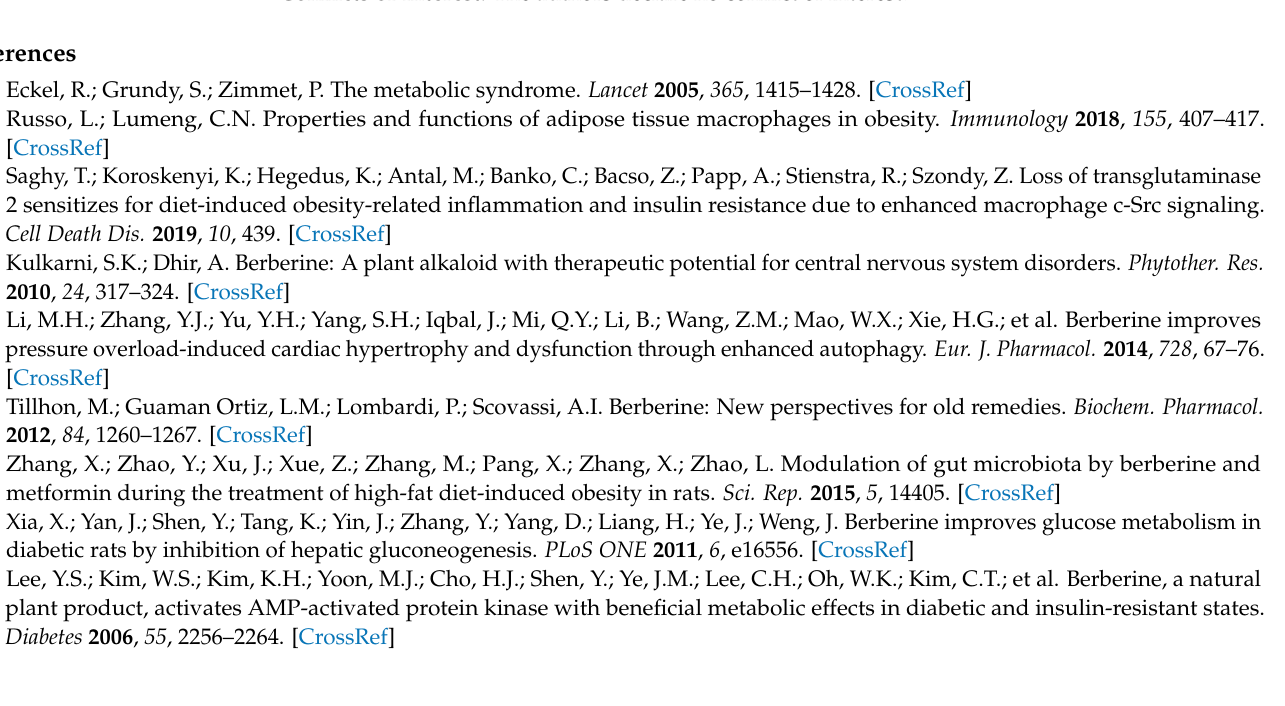
ministration; Table S1: Composition of high fat diets (D12492); Table S2: The primers used in reverse transcription